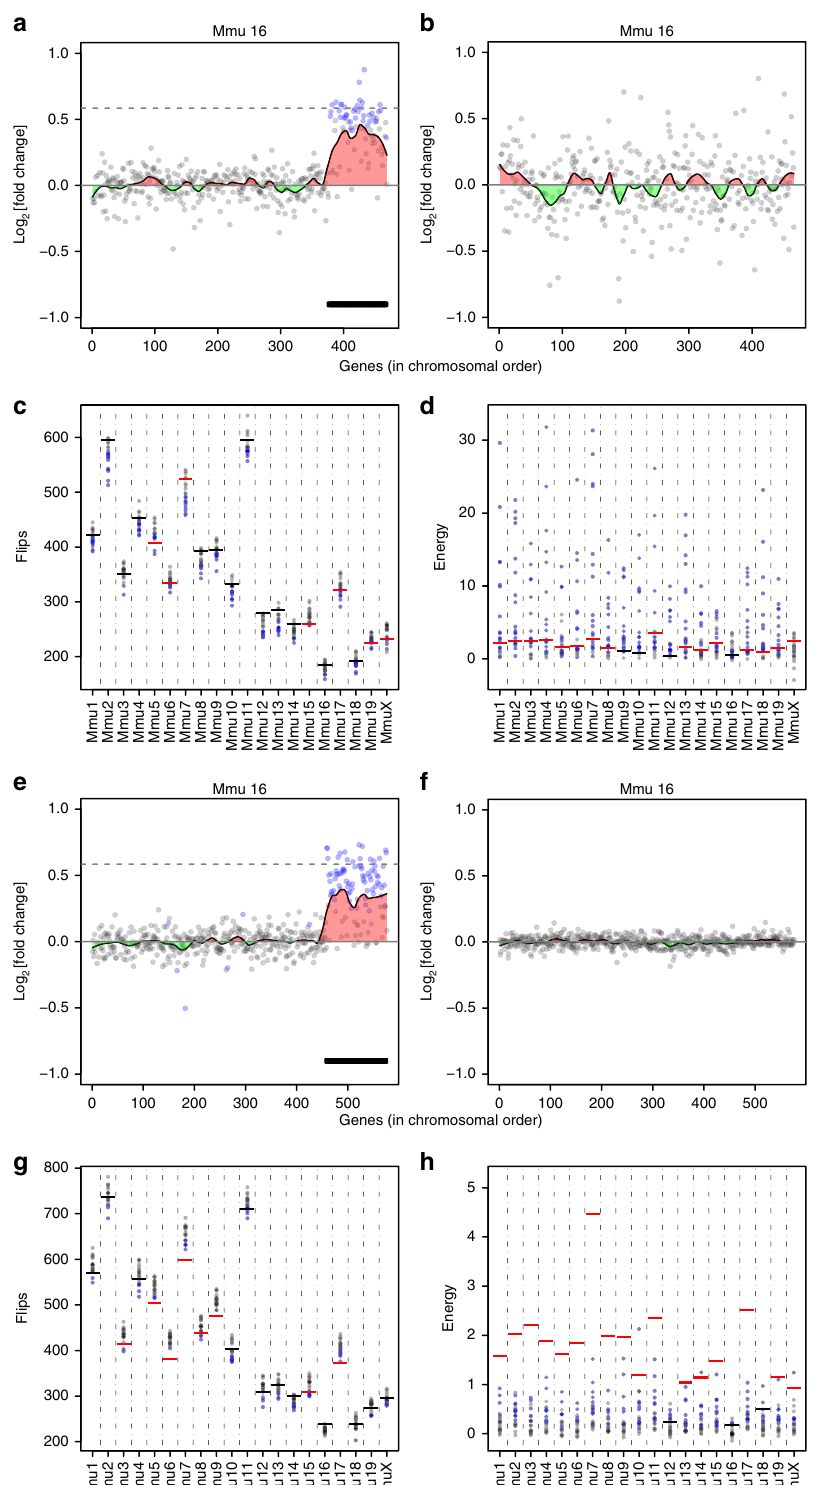
mapping panel of mouse duplication strains (Dp2Tyb